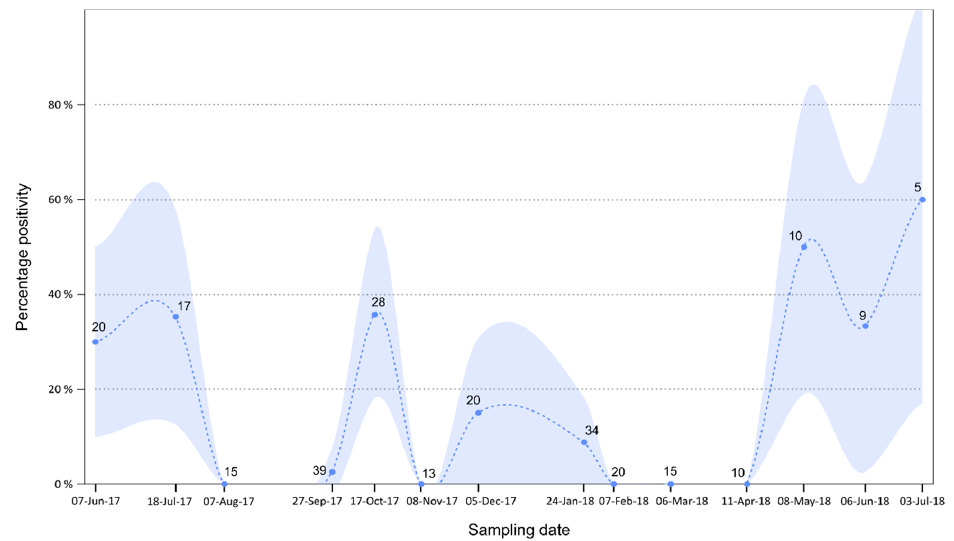
Figure 4. Temporal dynamics of rubulavirus excretion in urine within a Rousettus aegyptiacus population in South Africa detected with the Avula–Rubulavirus -specific primers [29]. Raw data are indicated by circles, and the dashed line shows values predicted by a loess function in R software [32]. Shaded areas represent 95% confidence intervals.